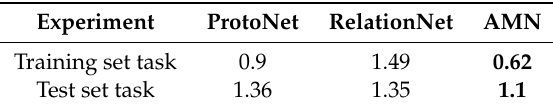
Figure 13. The PCA visualization results of task extracted from the first group of experiments on the NWPU-RESISC45 dataset. Different classes are marked with different colors. Top : training set task, Bottom : test set task. Table 7. The DBI of embedding features on a randomly selected training set task and a randomly selected test set task. The best results on each experiment are marked in